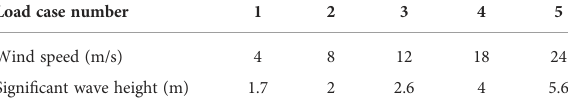
TABLE 5 Combined wind and wave conditions.